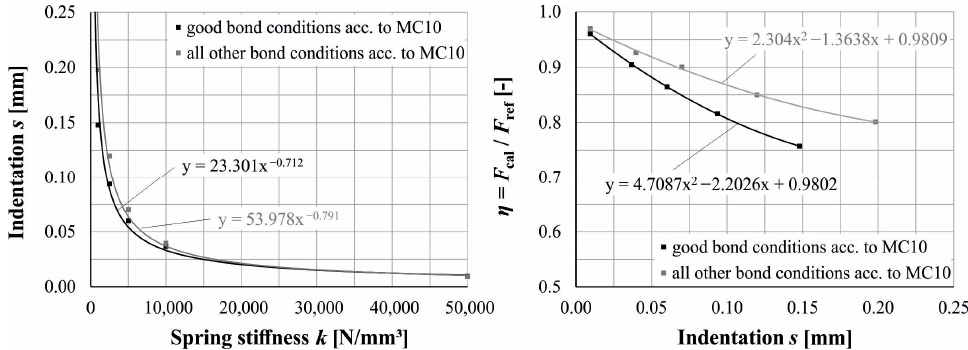
Figure 16. Relationship between modulus of spring stiffness and indentations ( left ) and reduction of ultimate load as a function of indentations ( right ).